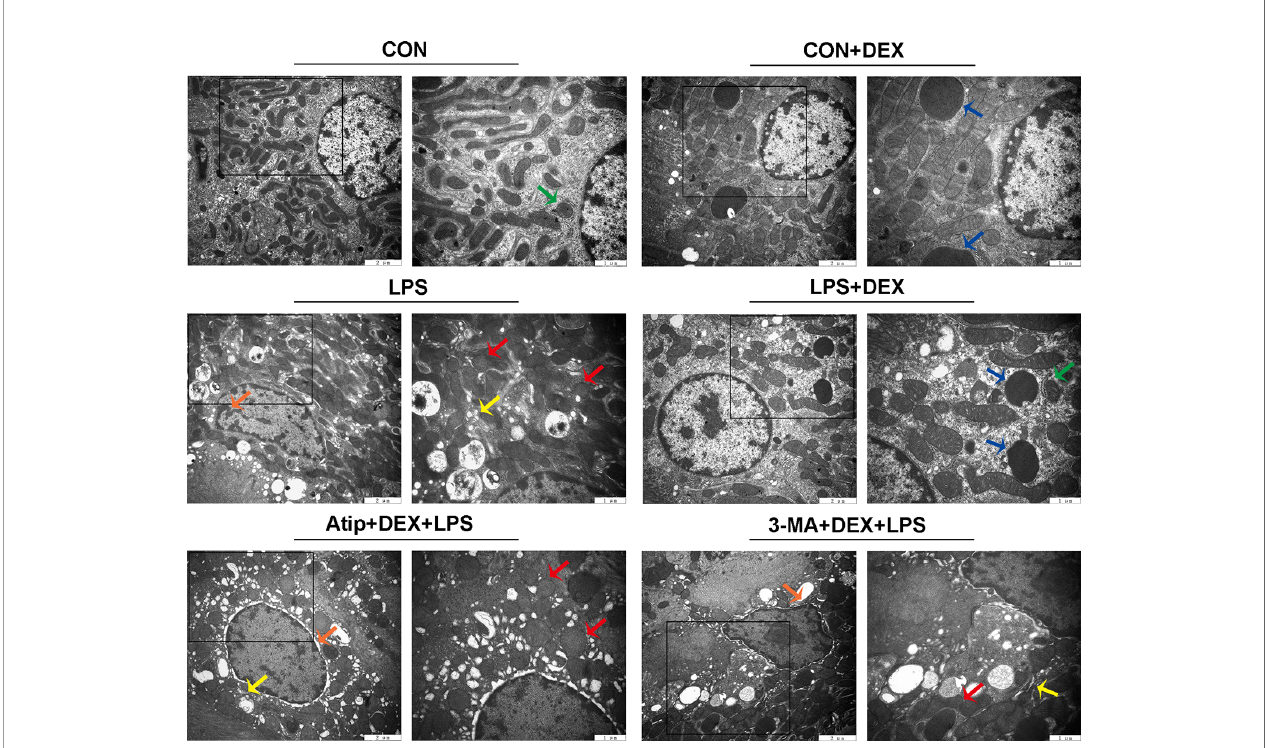
FIGURE 2 | The ultrastructure examination of the kidney. Representative ultrastructure samples from different groups. Red arrow indicates mitochondria appeared swelling, vacuolization and loss of cristae; orange arrow indicates chromatin margination, condensation, and fragmentation; yellow arrow indicates endoplasmic reticulum swelling; blue arrow indicates autolysosome; green arrow indicates mitophagy.